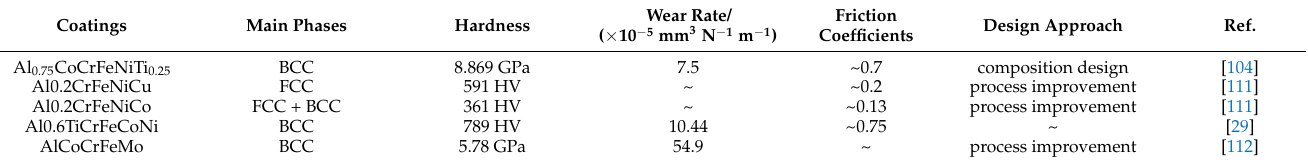
Table 3. The microstructure and tribological properties of HEA coatings prepared by thermal spraying.